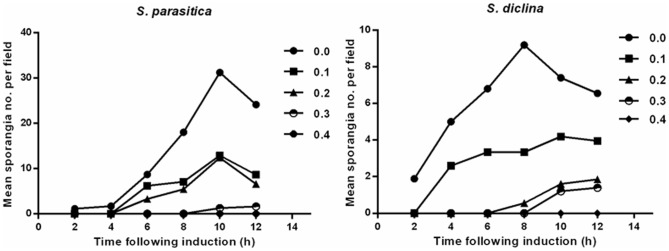
Effect of boric acid on the development and formation of Saprolegnia sporangia.The mean number of developed sporangia of two Saprolegnia sp. counted at 200× magnification following incubation with different boric acid concentrations.